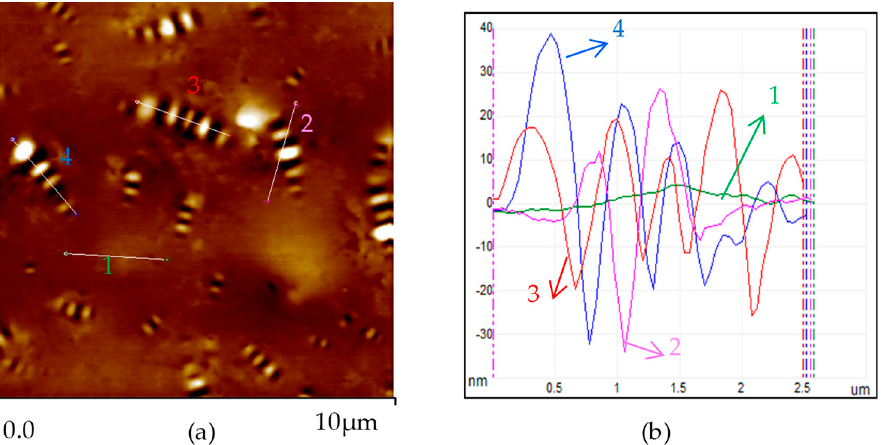
Figure 6. Height curves of representative areas in bitumen atomic force microscope (AFM) images ( a ) area selection; ( b ) height curves; (1) away from bee-like structure area; (2) bee-like structure and adjacent area; (3) and (4) bee-like structures.